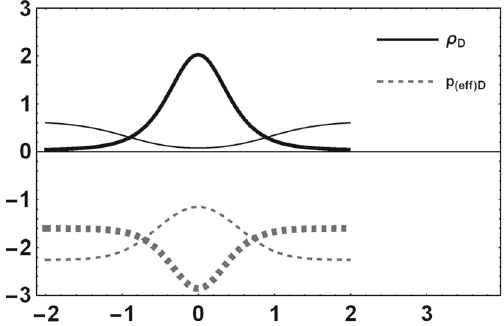
Fig. 6 Mutual behaviors of matter energy density and effective pres- sure related to the bounce solution in model D . The thin curves corre- spondtosolution(81)when ϒ = 0.Wehaveset α = − 2 . 7, (cid:16) D = − 0 . 1, m = − 0 . 8, ρ 0 = 2, a 0 = 1 . 2, (cid:14) D = 1 . 2 for thick curves and α = − 3, m = 0 . 2, ρ 0 = 0 . 1, a 0 = 1 . 1, (cid:14) D = − 0 . 2 for dashed